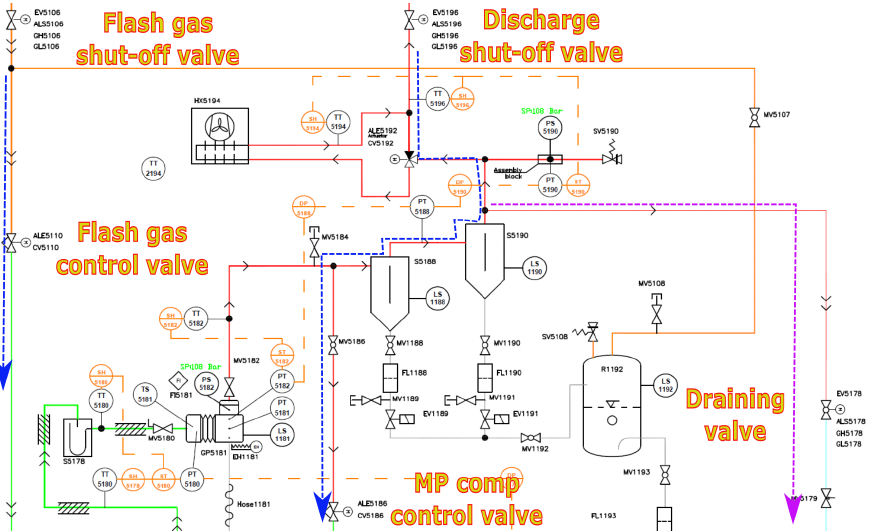
Figure 12. Flow path through flash gas controlled valve and MP compressor bypass valve (in blue) leading to over-pressurisation of low pressure side and draining path to return line through draining valve (in